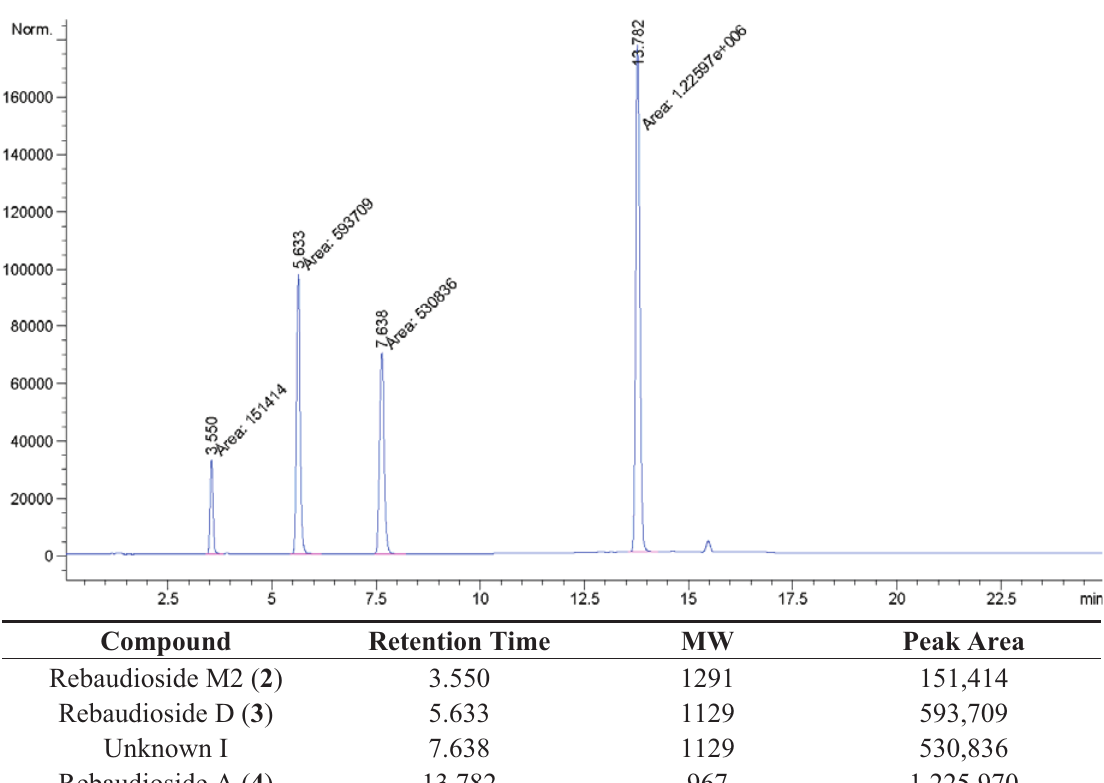
Figure 2. HPLC Chromatograph for the bioconversion of rebaudioside A ( 4 ) to rebaudioside D ( 3 ) and minor product rebaudioside M2 ( 2